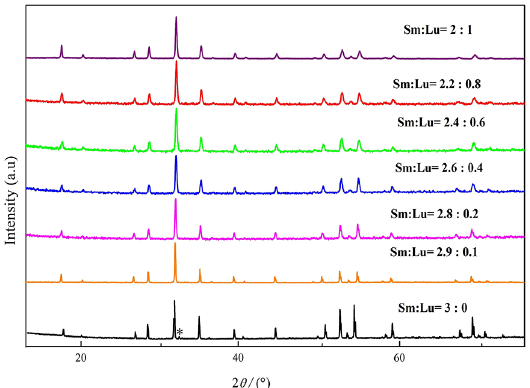
REE Fe O 3− x x 5 12 3